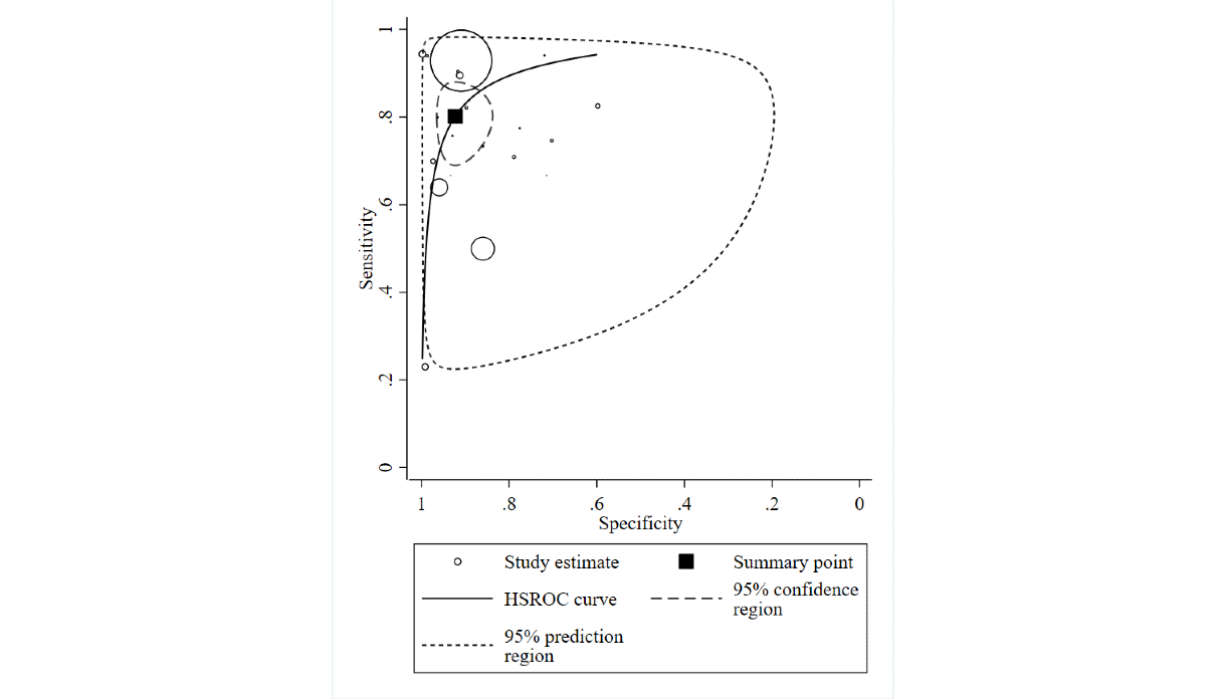
Figure 2. Hierarchical summary receiver-operating characteristic (HSROC) curve for prediction of hypoglycemia using machine learning algorithms. Circles indicate study-specific sensitivity and specificity for each of the 19 included studies. The size of each circle is proportional to study sample size. The pooled point estimates of sensitivity and specificity are plotted in a filled